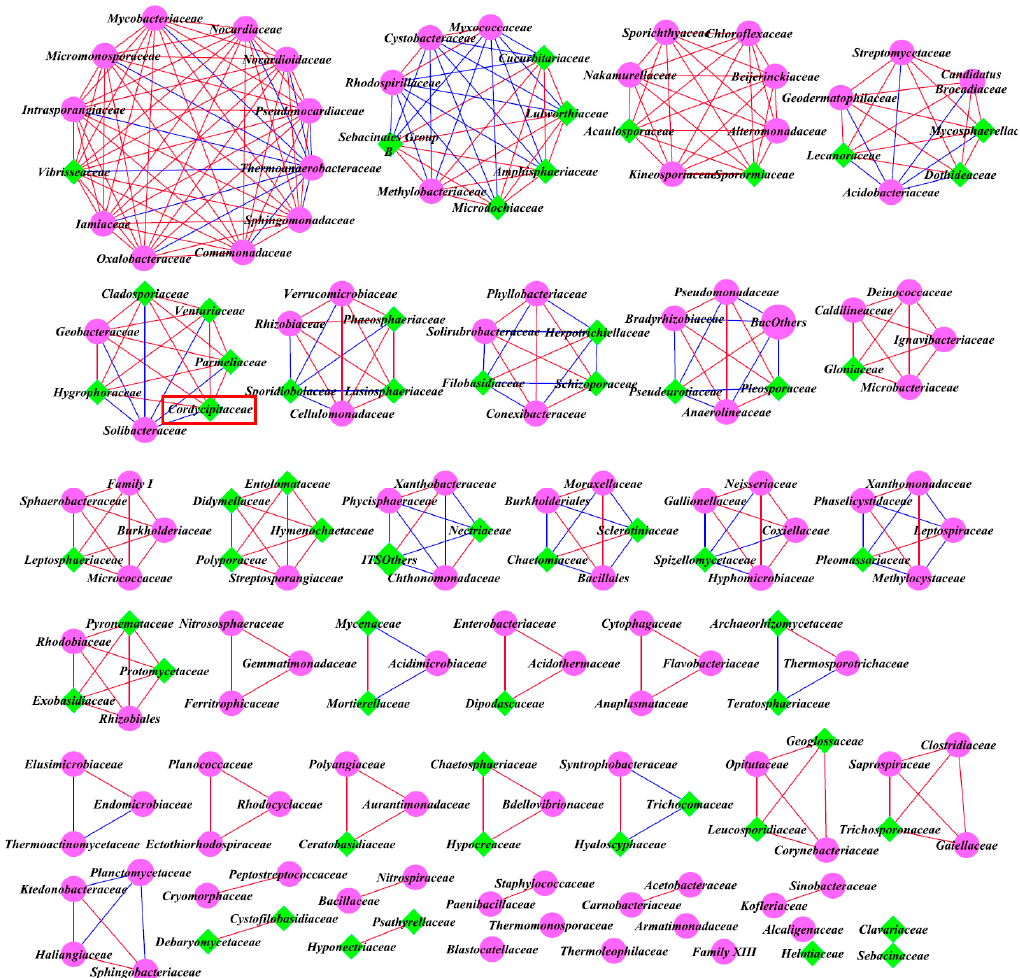
Figure 9. Inter-kingdom network of differentially abundant fungal and bacterial families at site A. Highly significant positive ( R > 0.80, FDR < 0.05) and negative ( R < − 0.80, FDR < 0.05) Pearson correlations are represented by red and blue lines. The size of each node is proportional to the degree. Fuchsia circles: bacterial kingdoms, green diamonds: fungal kingdoms, red rectangle highlights Cordyceps -related family.